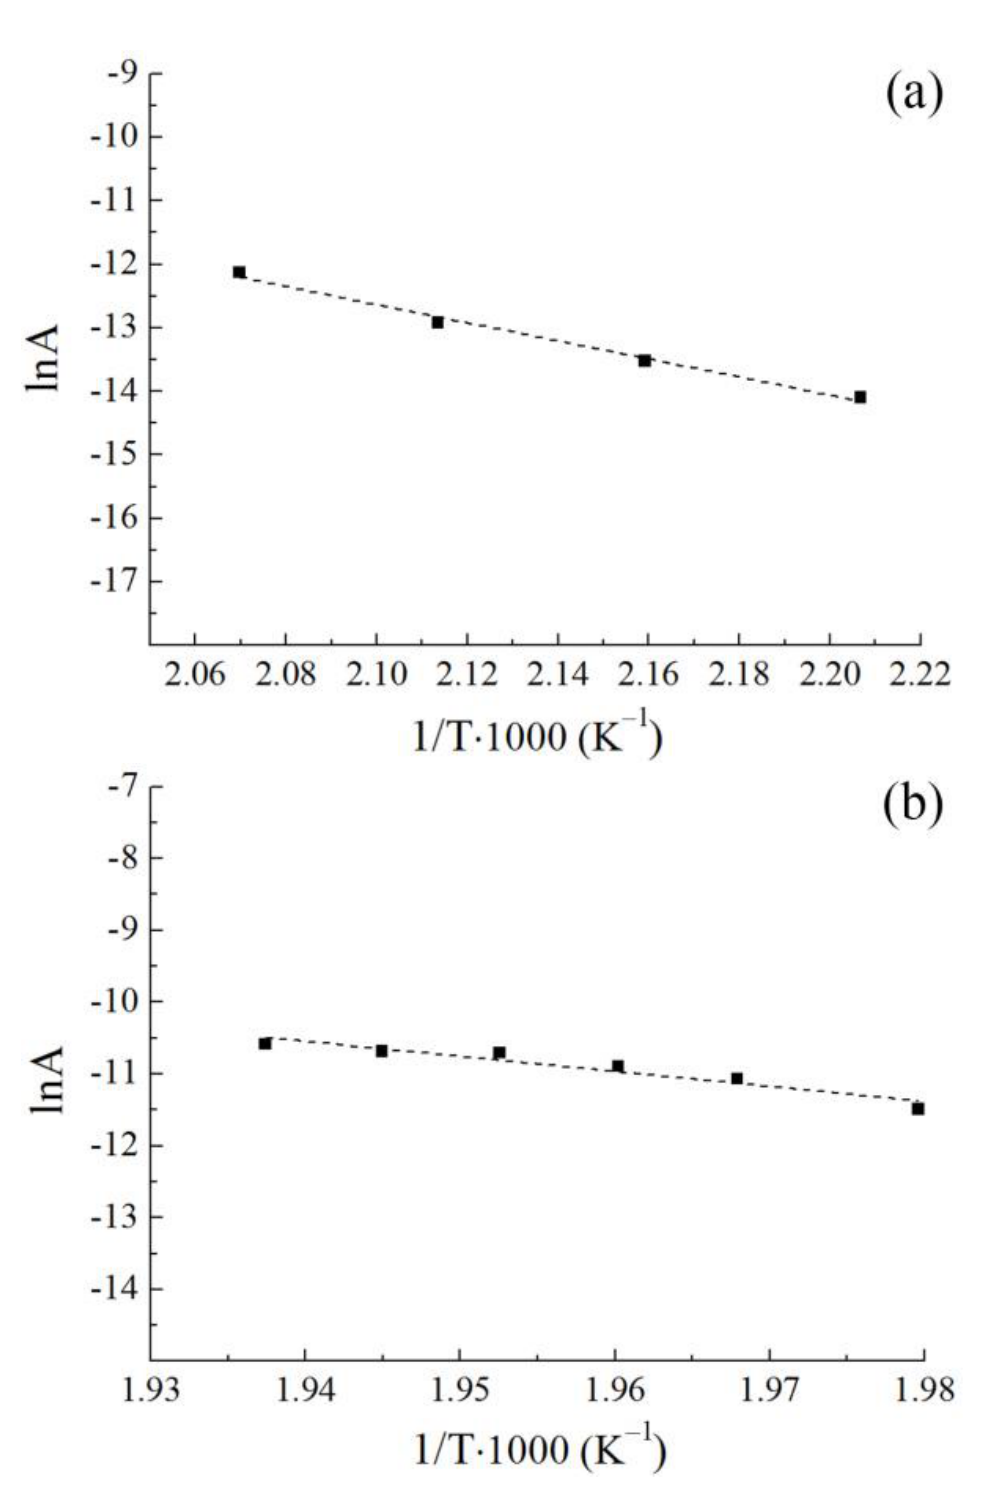
Figure 5. Catalyst activity versus temperature at 300 hr −1 and 2 MPa in two temperature ranges: 180–210 ( a ) and 232–234 ◦ C ( b ). Activation energy for the temperature range 232–243 ◦ C is calculated from the tangent